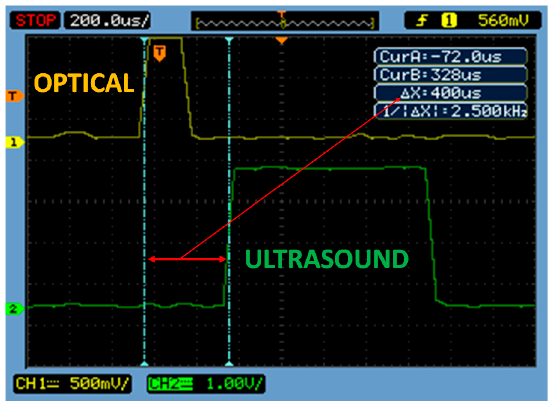
Figure 6. Experimental delay measurement, received by the mobile node (note that the scope denotes us for µs).